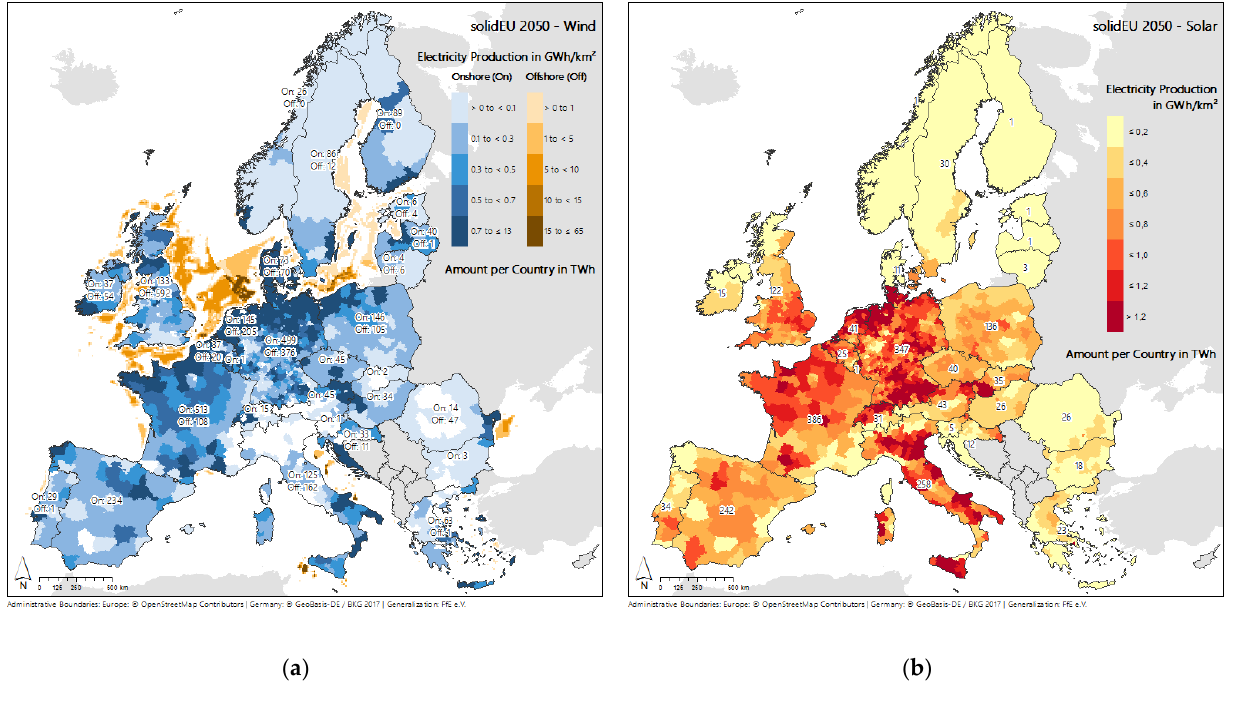
Figure 8. Regional distribution (NUTS-3) of electricity production per square kilometer in Europe for: ( a ) on- and off-shore wind capacities; ( b ) PV capacities. Own figure based on [30]. Differences due to consideration of curtailment of vRES and exclusion of the Balkan countries as they are not relevant for the scope of this scenario.